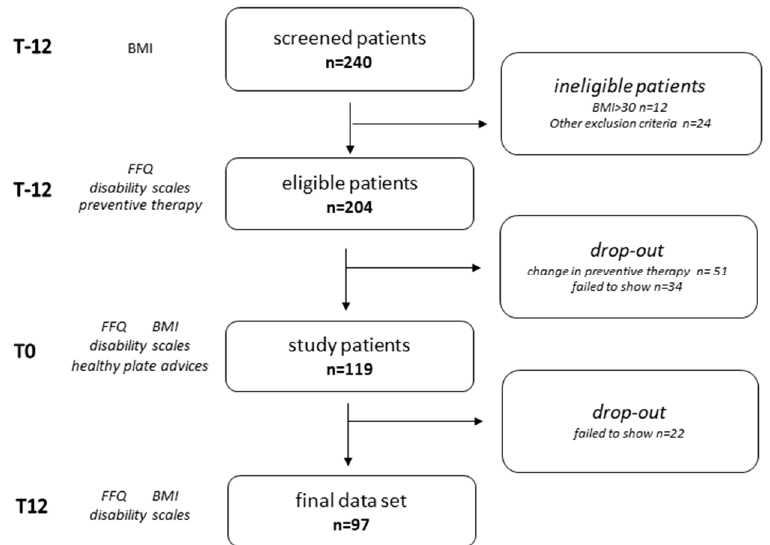
Figure 1. Study design and population at the three evaluation times. T-12: screening, 12 weeks before the intervention; T0: time of the educational intervention; T12: follow-up, after 12 weeks; FFQ: food frequency questionnaire; BMI: body mass index.